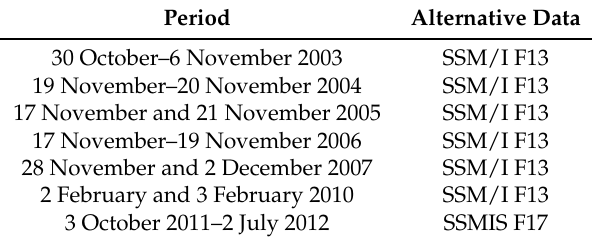
Table 2. List of dates on which the AMSR-E/AMSR2 sea ice data were not available and alternative sensors used for sea ice detection. SSM/I, Special Sensor Microwave Imager; SSMIS, Special Sensor Microwave Imager